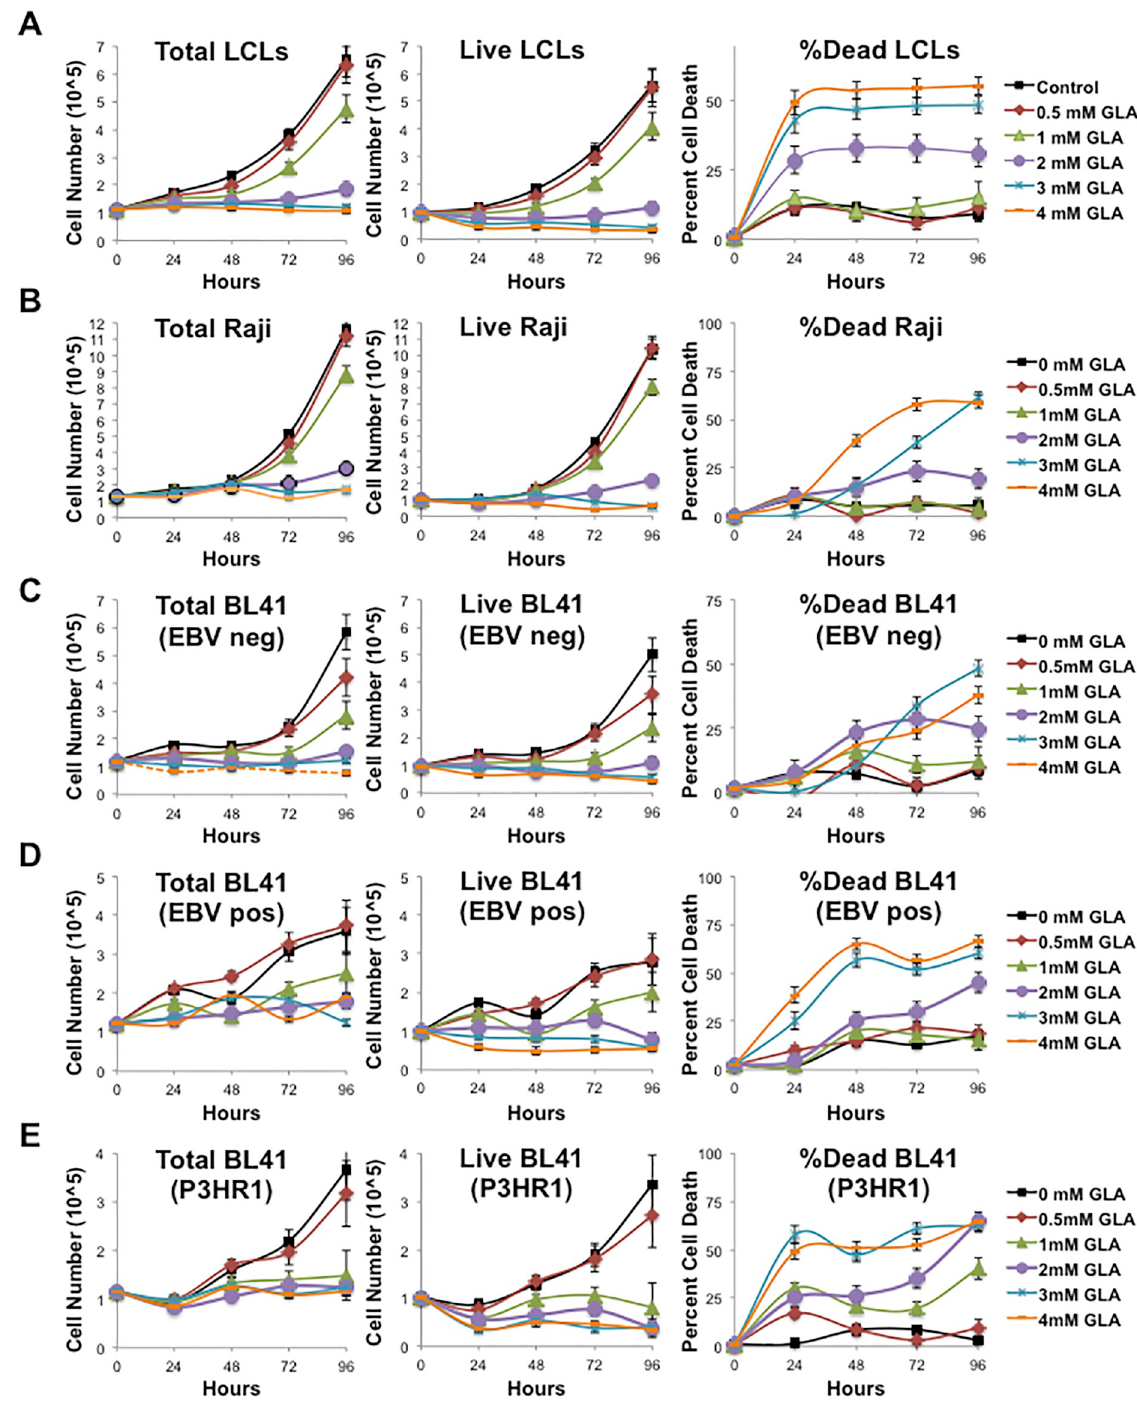
Fig 2. Glycyrrhizic acid affected growth and survival. A) EBV-transformed LCLs, B) Raji cells, C) EBV-negative BL 41 cells, D) EBV- positive BL 41 cells, and E) P3HR1-infected BL 41 cells were treated with graduated doses of glycyrrhizic acid and total cell number (left), live cell number (middle), percent cell death (right) were determined. Results are shown as the means ± the standard deviation of a representative experiment of samples run in triplicate and experiments performed in triplicate.